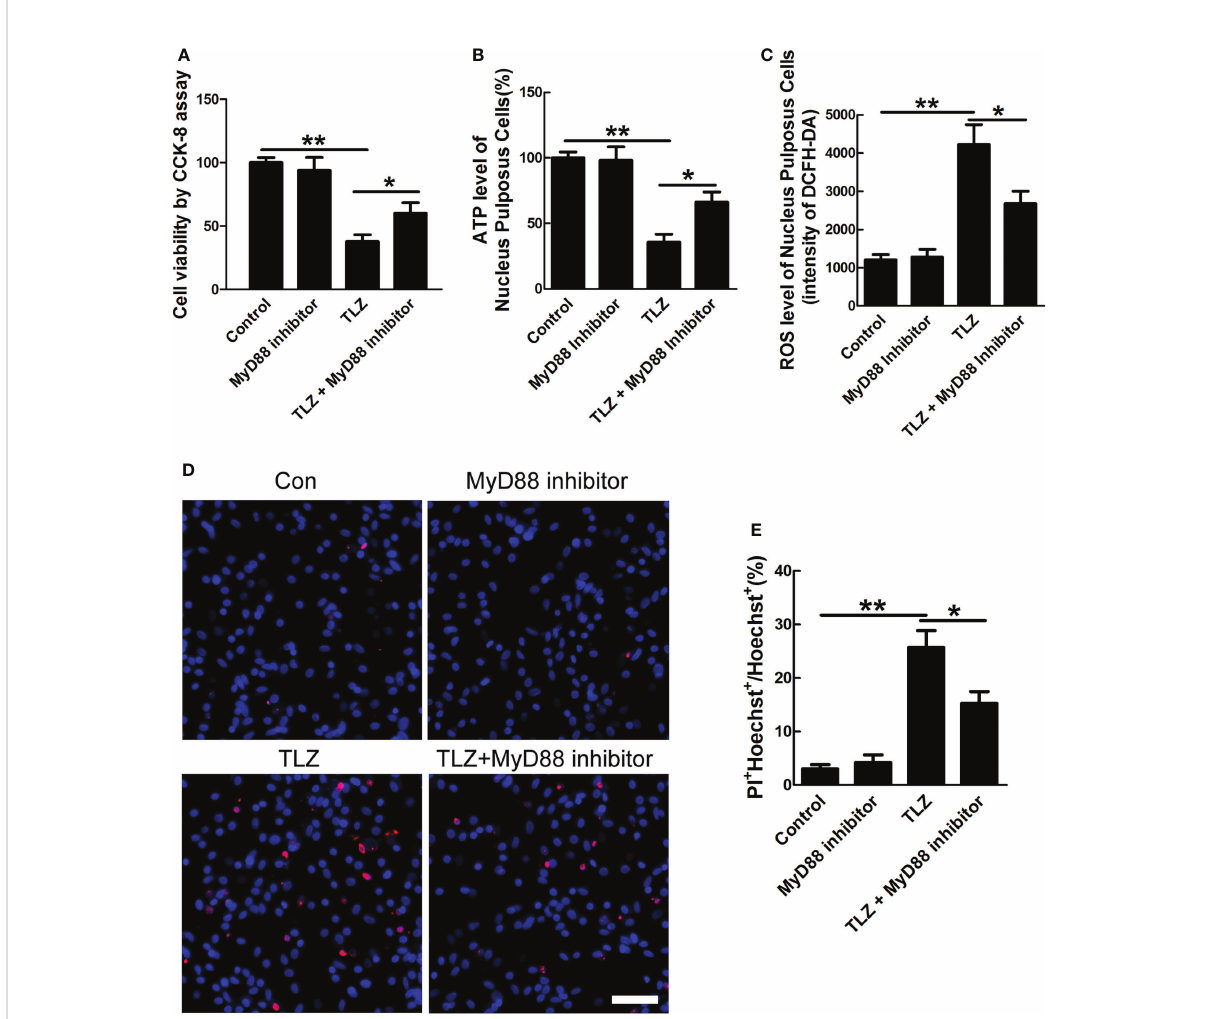
FIGURE 4 Effects of MyD88 signaling on necroptotic NP cells. (A) NP cells viability under TLZ with MyD88 inhibitor condition. (B) ATP level of necroptotic NP cells with blocking MyD88 signaling. (C) ROS level of NP cells with different conditions. (D) PI-positive cells under TLZ condition with or without MyD88 inhibitor. (E) Relative percentage of PI+ NP cells. *P < 0.05, **P < 0.01. N= 3 independent replicates. Bar = 50 m